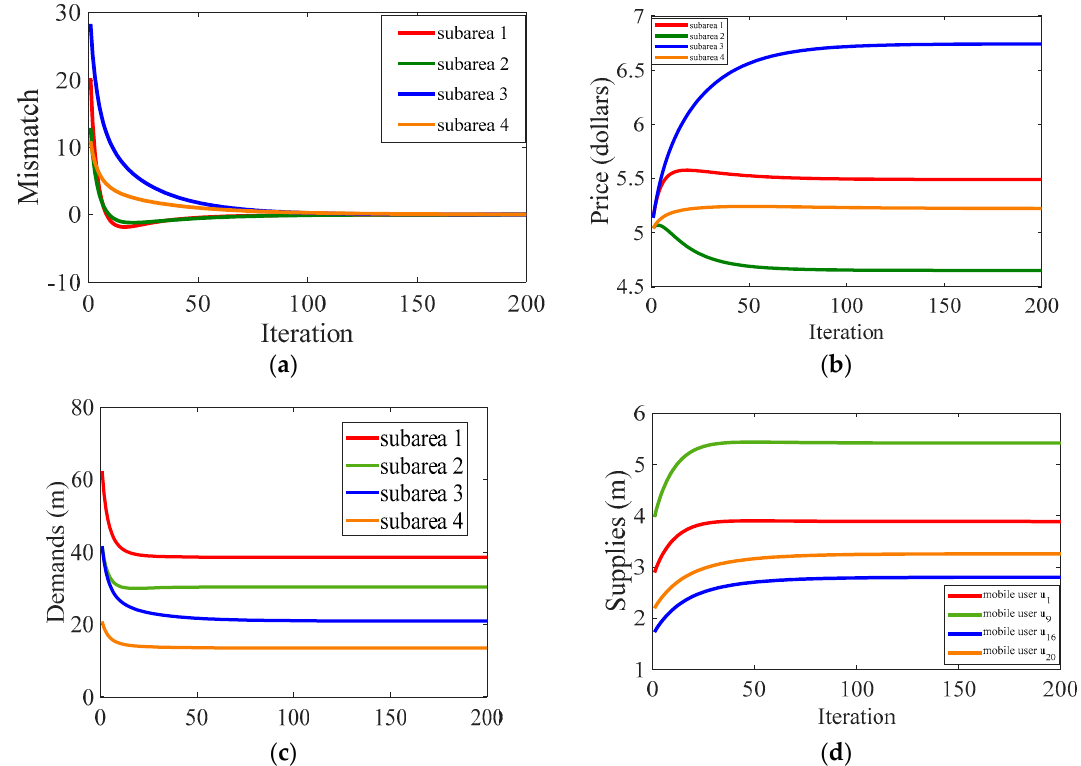
Figure 2. Verification of convergence for ( a ) mismatch between demand and supply, ( b ) price of trajectory, ( c ) demand of the crowdsourcer, and ( d ) supply by mobile user 𝒖 𝟏 , 𝒖 𝟗 ,𝒖 𝟏𝟔 , and 𝒖 𝟐𝟎 .